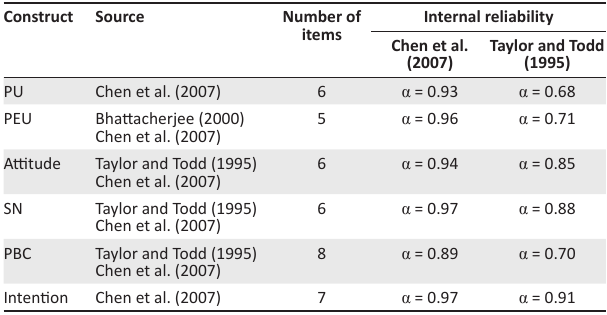
TABLE 1: The instruments used in the study.